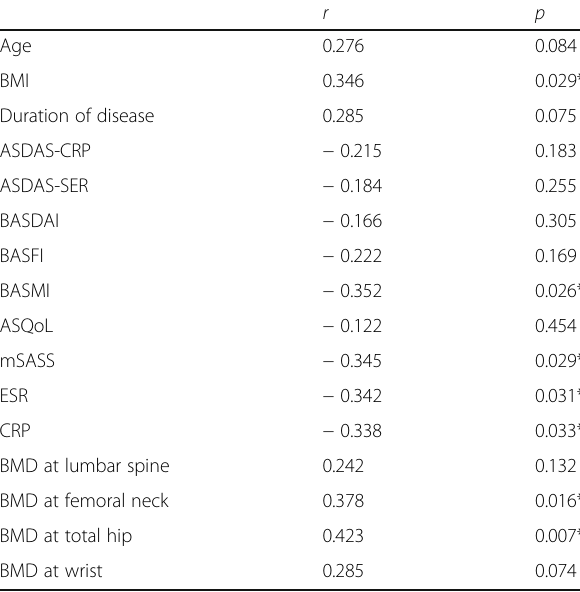
Table 4 Correlation of TBS with age, BMI, clinical features, composite indices, and laboratory findings of ankylosing spondylitis patients